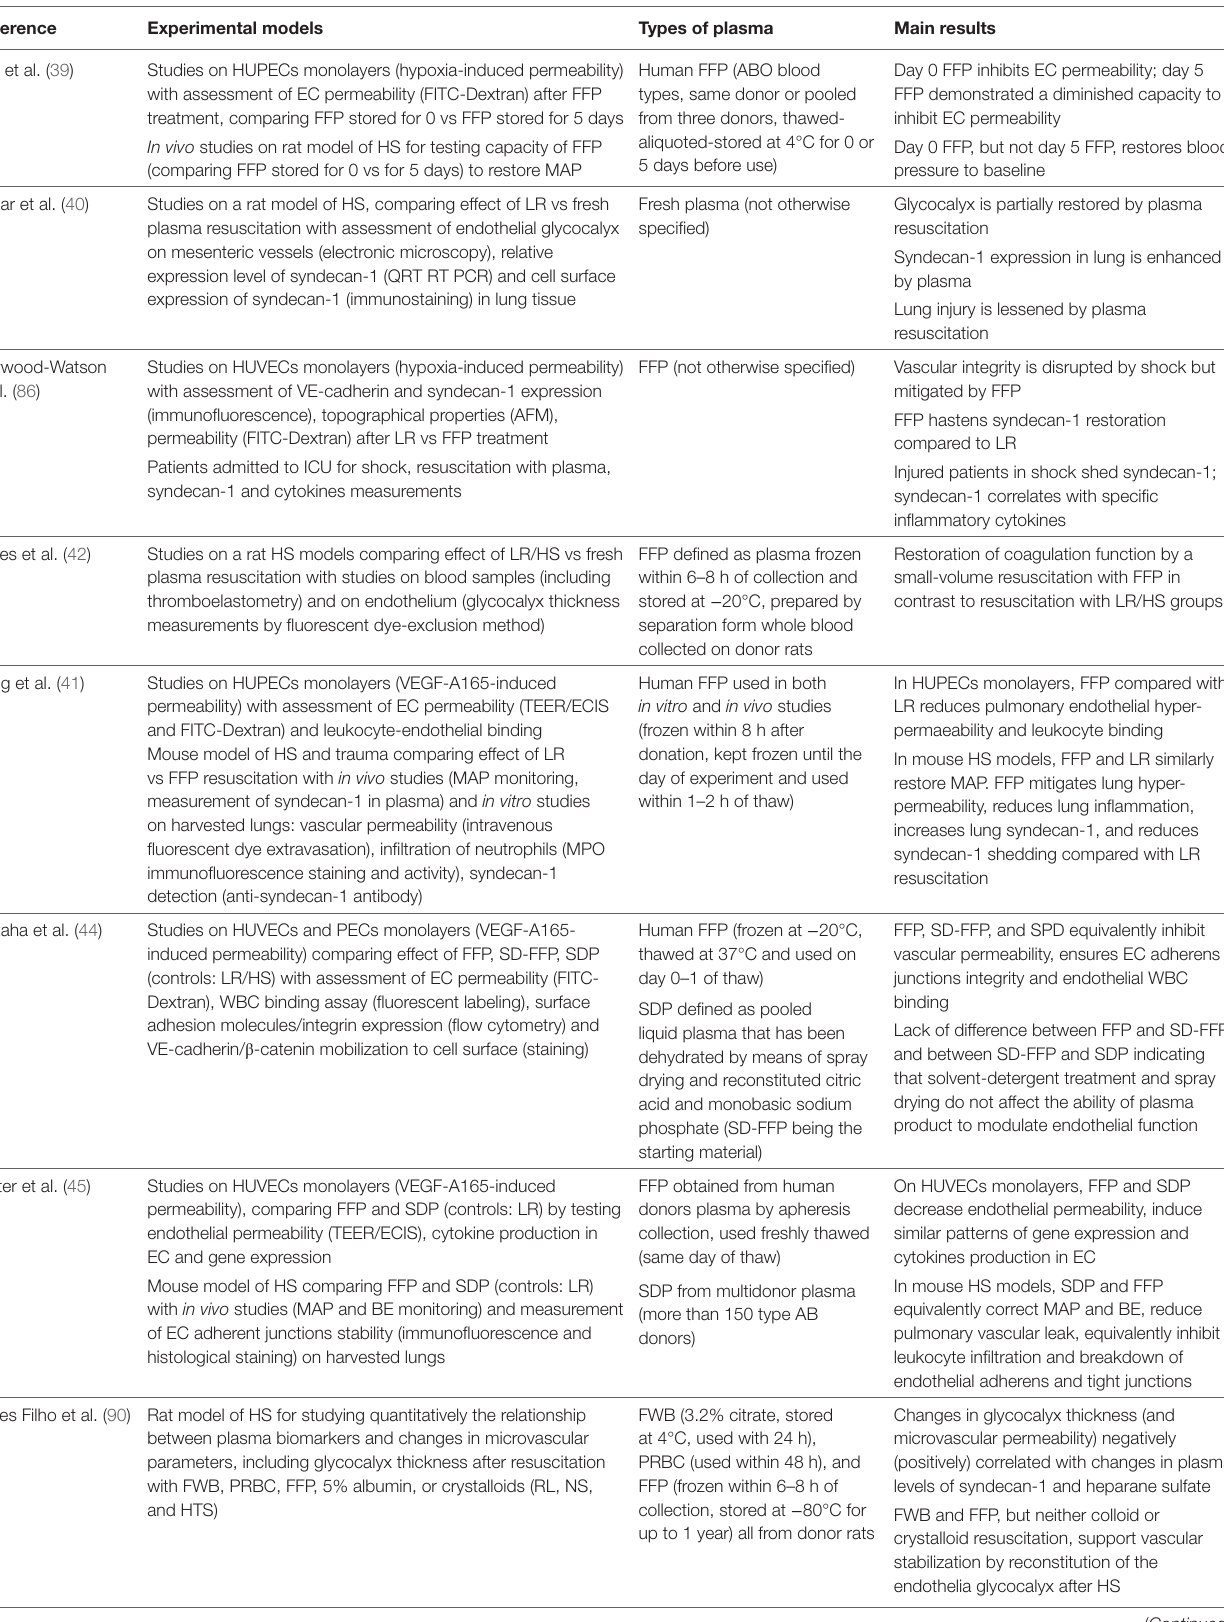
TABLe 2 | Studies a investigating endothelial integrity through plasma exposition in HS